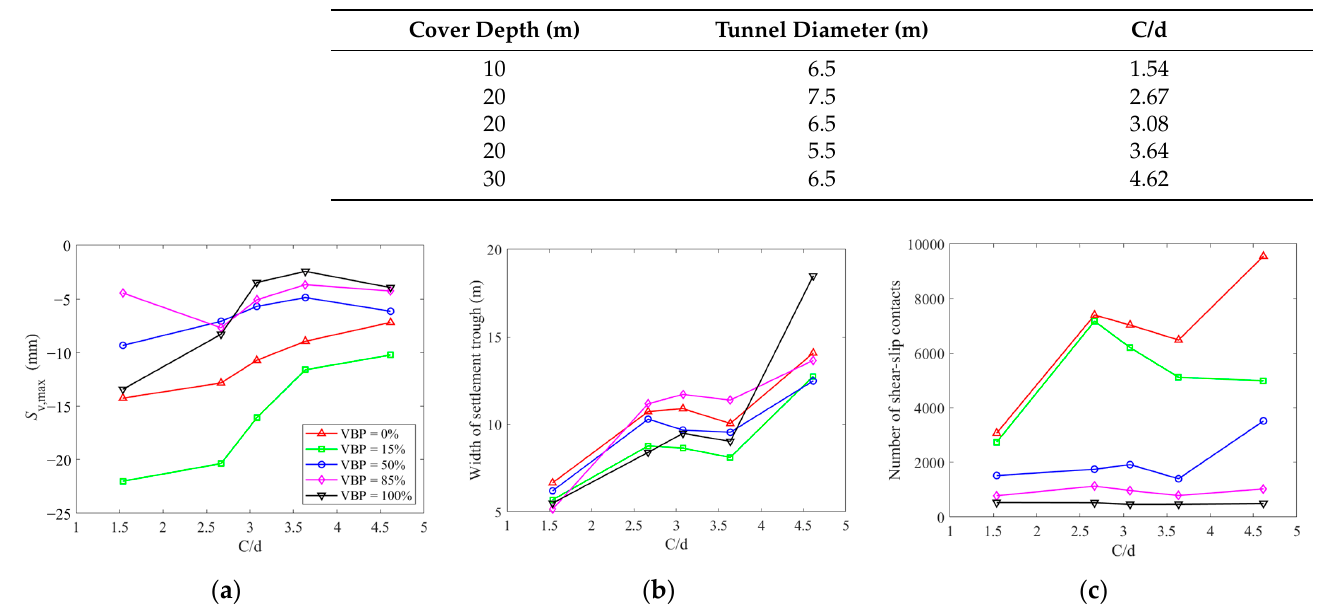
Figure 19. The fitting results for the ground settlements using Peck formula as a function of C/d: ( a ) maximum ground settlement, ( b ) width of settlement trough, and ( c ) number of shear-slip contacts as a function of C/d.